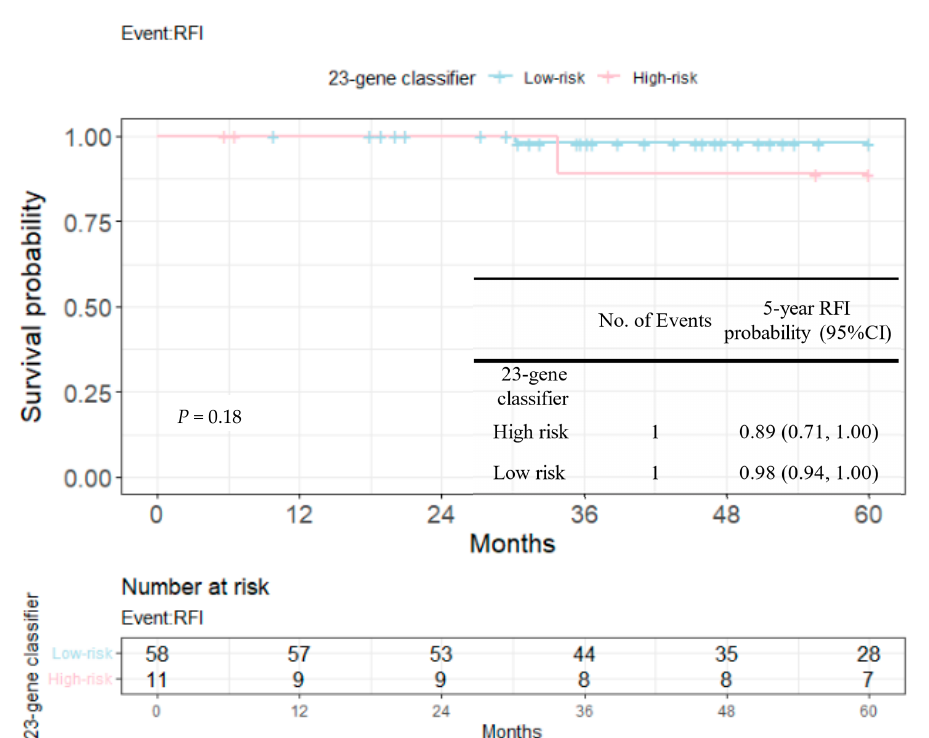
Figure 6. Kaplan–Meier plot for RFI within 5 years in clinically low-risk group to compare the partition of 23-gene classifier. Blue: genetic low-risk group; red: genetic high-risk group.